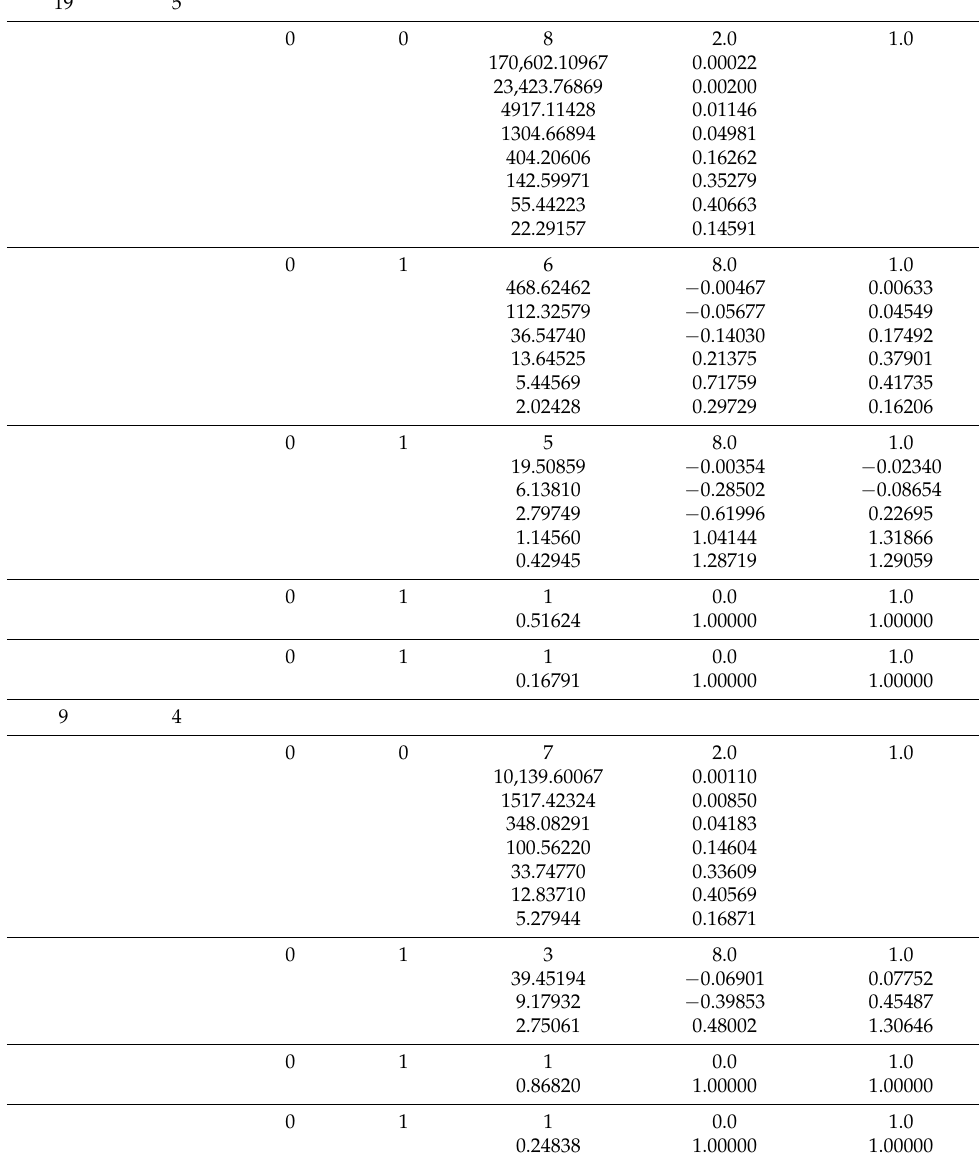
Table A2. K and F all electron basis set used in the present calculations.